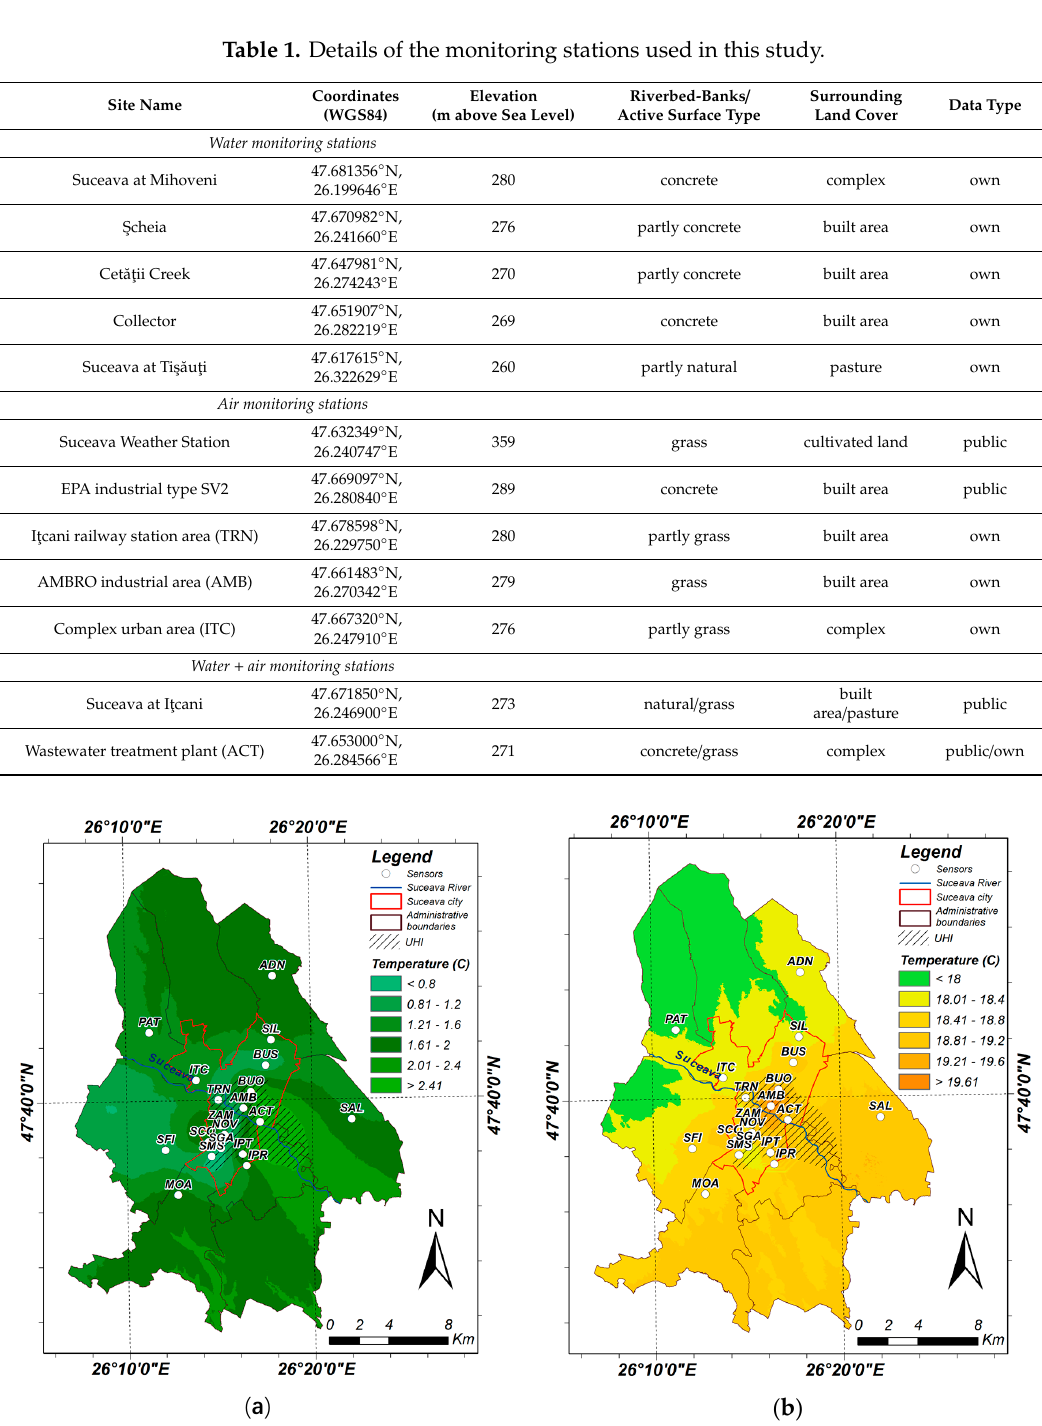
Figure 2. Urban heat island (UHI) above Suceava metropolitan area as revealed by hourly air temperature measurements in 2019 during winter—( a ) (December, January, February)—and summer months—( b ) (June–August)—UHI represents the area most impacted by the urban heat island.